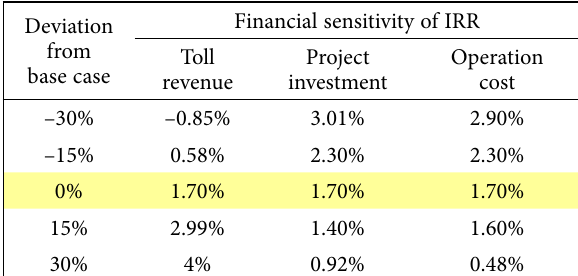
Table 7. Internal rate of return (IRR) sensitivity analysis Deviation from